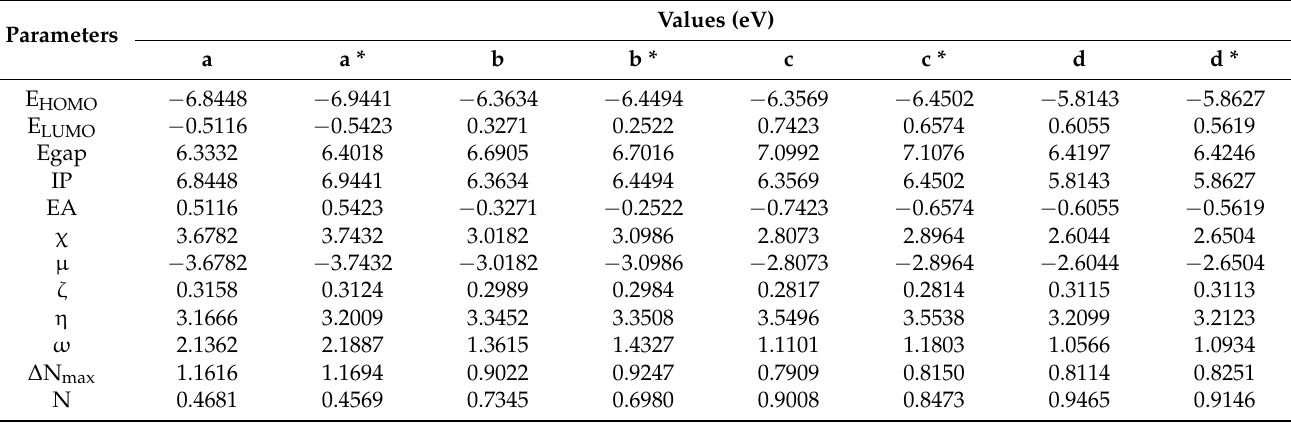
Table 3. Some electronic properties of studied molecules (a–d) calculated by the DFT/B3LYP method in the gas phase and water